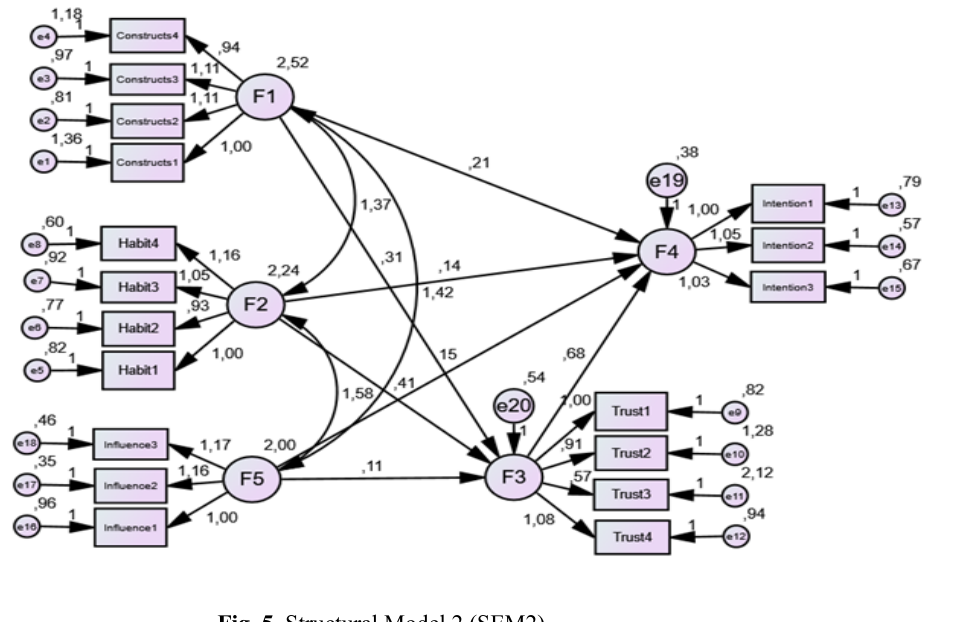
Fig. 5. Structural Model 2 (SEM2)